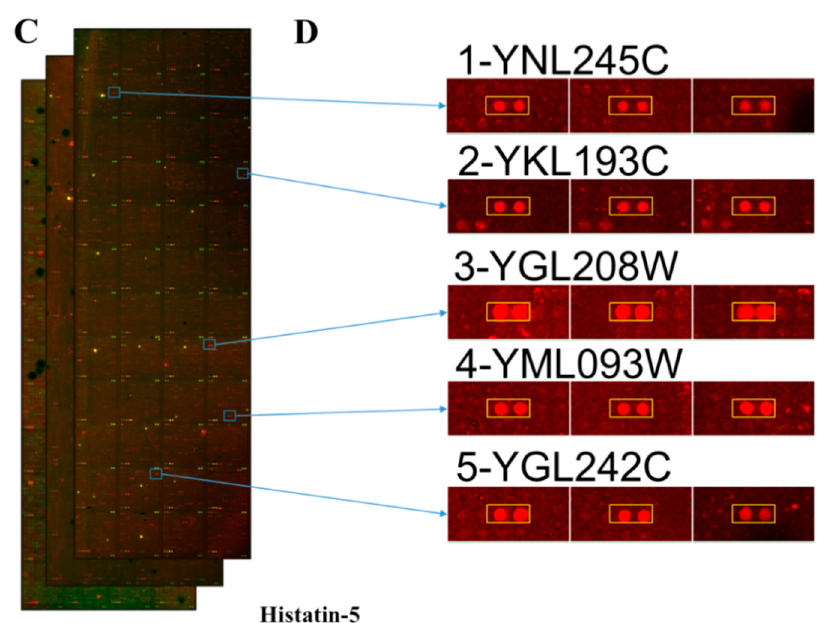
Figure 2. The representative yeast proteome microarray images and the representative hits of Lfcin B and Histatin-5 on yeast proteome microarrays. Images show the microarray and the enlarge hit image of Lfcin B and Histatin-5. Red and green color denotes the signal from DyLight 650 labeled streptavidin and DyLight 550 labeled anti-GST antibody, respectively. Red spots represent the signal of Lfcin B and Histatin-5 on yeast proteome microarrays. ( A ) Triplicate microarray images probed with biotinylated Lfcin B. The position of the representative 5 hits image is shown on the microarray. ( B ) Representative enlarged hits images of Lfcin B. ( C ) Triplicate microarray images probed with biotinylated Histatin-5. ( D ) Representative enlarged hits images of Histatin-5.